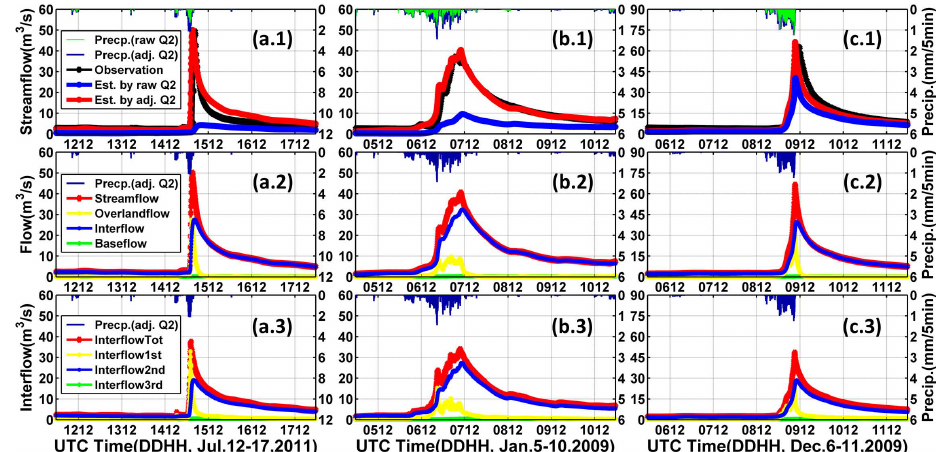
Fig. 8. The comparison between simulated streamflow at the outlet of the CCB, generated from the 3D-LSHM driven by Q2 rainfall datasets before and after adjustment for the event in July of 2011 (a) , and in January (b) and December (c) of 2009; the flow components of estimated streamflow by adjusted Q2 including overland flow, interflow and baseflow are shown in the middle row (a.2, b.2 and c.2); and the interflow produced from three soil layers are shown in the bottom. The upper and right axis in figures indicate basin areal averaged storm hyetograph.